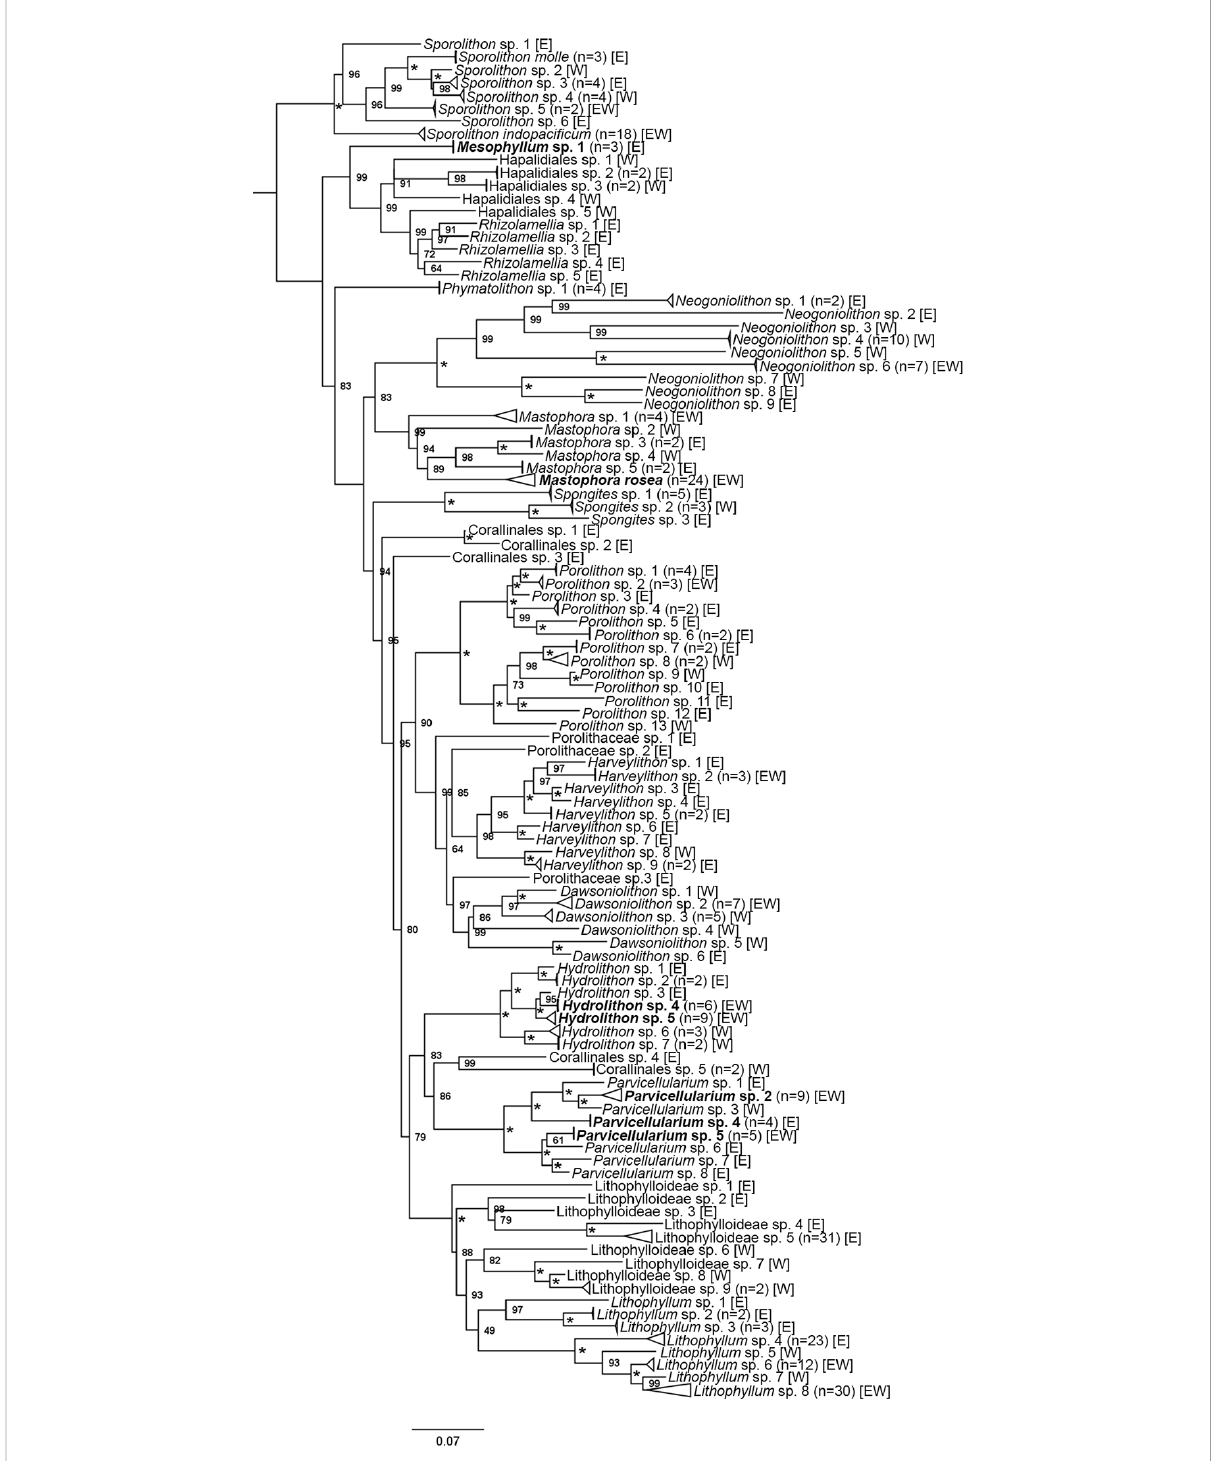
FIGURE 2 Maximum likelihood phylogenetic tree of concatenated COI-5P and psb A sequences for all specimens in the subclass Corallinophycidae collected during this study with bootstrap support values located at the nodes. Asterisks (*) denote nodes with full support. The side of the island that each species was found is shown using [E] for east side, [W] for west side, and [EW] for both sides. Tips denote putative species (n=106). Species recognized by ABGD, but split into one or two additional sister species by bPTP species delimitation are in bold type. Batrachospermum gelatinosum (Linnaeus) De Candolle was used as the outgroup and pruned from the depicted